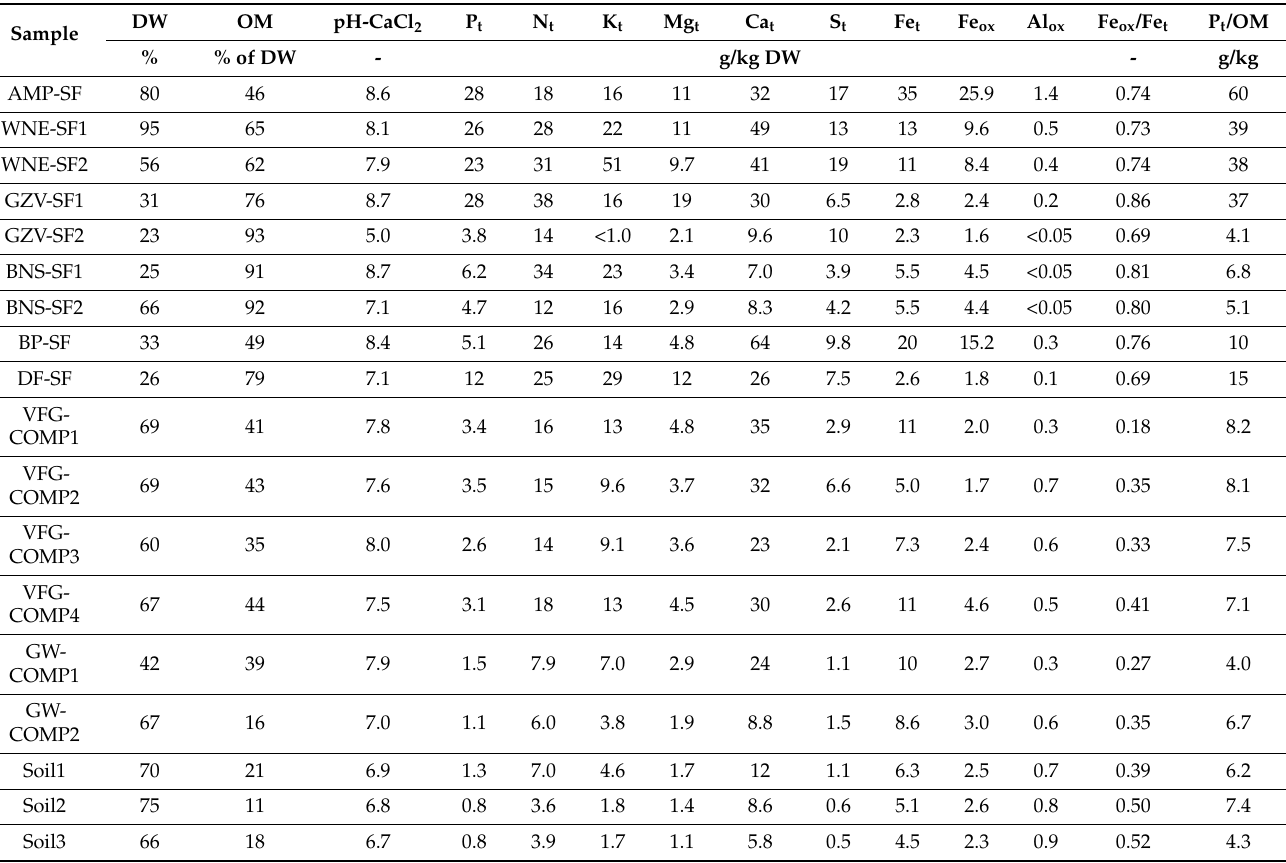
Table 3. Composition of the studied solid fractions (SF’s) of digestate, composts (COMP) and sieved soils (soil) expressed on dry weight (DW) a, b